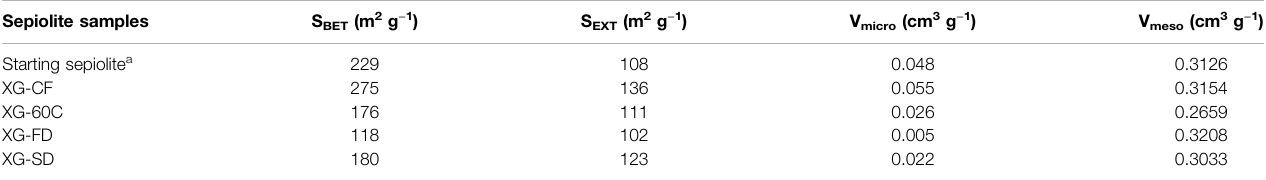
TABLE 2 | Values of BET speci fi c surface area, external surface area (S EXT ), micropore volume (V micro ) and mesopore volume (V meso ) deduced from the N 2 adsorption- desorption isotherms of xerogels samples prepared by different drying procedures. Sepiolite samples